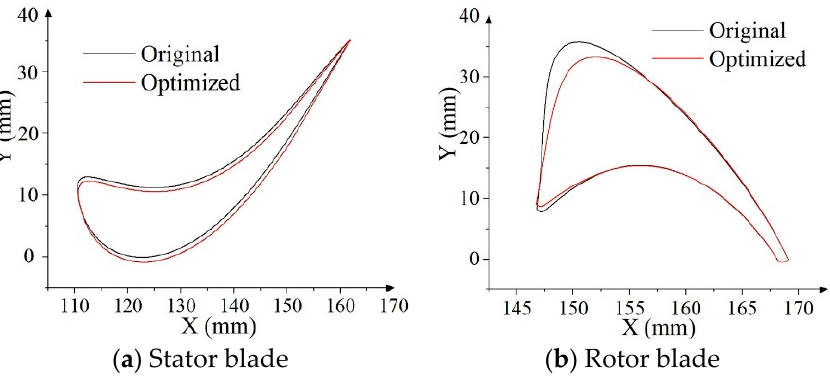
Figure 13. Comparison of the multipoint optimized blade with the original blade.